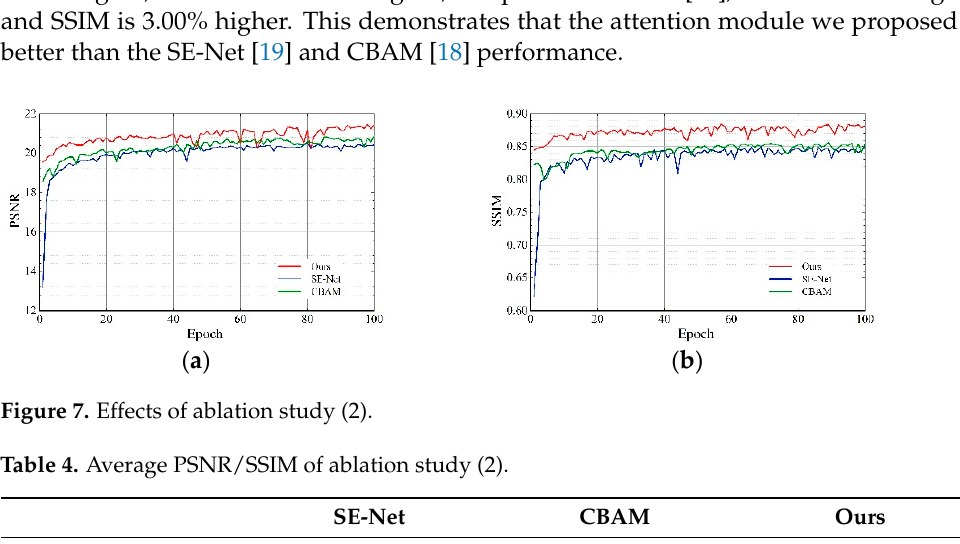
Table 3. Average PSNR/SSIM of ablation study (1).